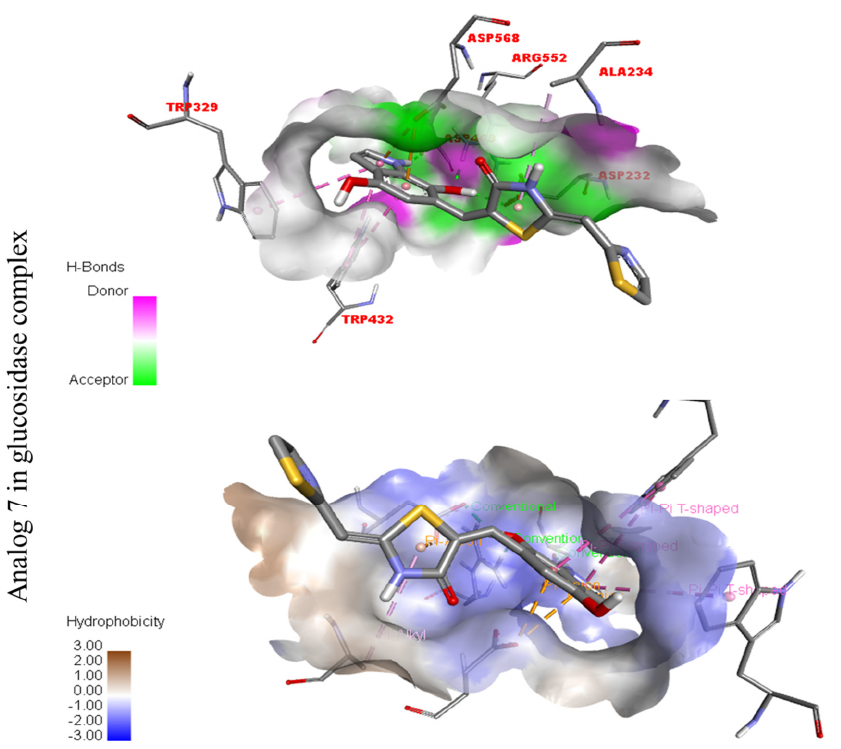
Figure 14. Represent hydrogen bond and hydrophobic character against Alpha-glucosidase indicate the PLI profile for compound 7 . Resultantly, it was observed that analogs four and five were found to have excellent potential against targeted enzymes. It might be that the presence of electrons withdrawing and donating groups, respectively, increased the binding modalities with different inter- actions such as pi-anion, pi-cation, pi-sulfur, hydrogen bonding, and pi–pi interaction. The interactive ability of these scaffolds is due to the presence of benzene rings and dif- ferent heteroatoms. 3. Experimental Section 3.1. Material and Methods For the synthesis of desired compounds, all the chemicals and reagents were pur- chased from the USA (Sigma Aldrich). Thin layer chromatography (TLC) was performed on pre-coated silica gel aluminum plates (Kieselgel 60,254, E. Merck, Germany). Chroma- tograms were visualized by UV at 254 and 365 nm. High-resolution electron impact mass spectra (HREI-MS) were recorded on a Finnigan MAT-311A (Germany) mass spectrome- ter. NMR experiments were performed on an Avance Bruker AM 600MHz machine. 3.2. General Procedure for the Synthesis of Thiazolidinone-Based Indole Derivatives ( 1–20 ) The mixture of 2-aminothiazole (I, 1 equivalent ) and ammonium isothiocyanate (1 equivalent) was mixed in methanol (10 mL), and the reaction mixture was refluxed in the presence of glacial acetic acid to yield thiazole-based thiourea analog (II), which was then treated with chloroacetic acid (1 equivalent) under reflux in acidic medium and afforded